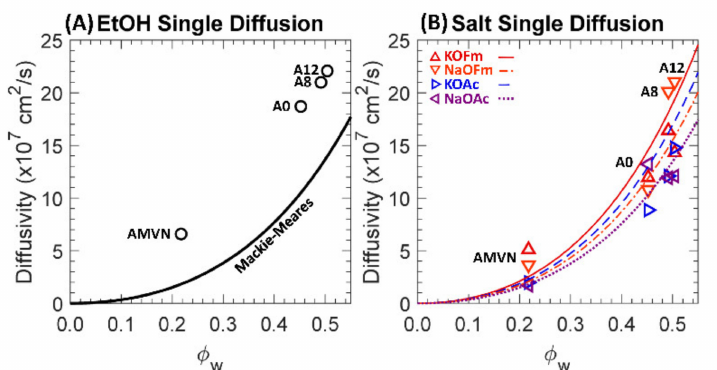
Figure 9. ( A ) Diffusivities to EtOH, , in single diffusion. The solid line is the Mackie–Meares’ fit. (cid:35) ( B ) Diffusivities to KOFm ( (cid:52) , red), NaOFm ( (cid:53) , orange), KOAc ( (cid:46) , blue) and NaOAc ( (cid:47) , purple) in single diffusion. The lines are the Mackie–Meares’ fits, KOFm (solid line, red), NaOFm (dot-dashed, orange), KOAc (dashed, blue) and NaOAc (dotted,